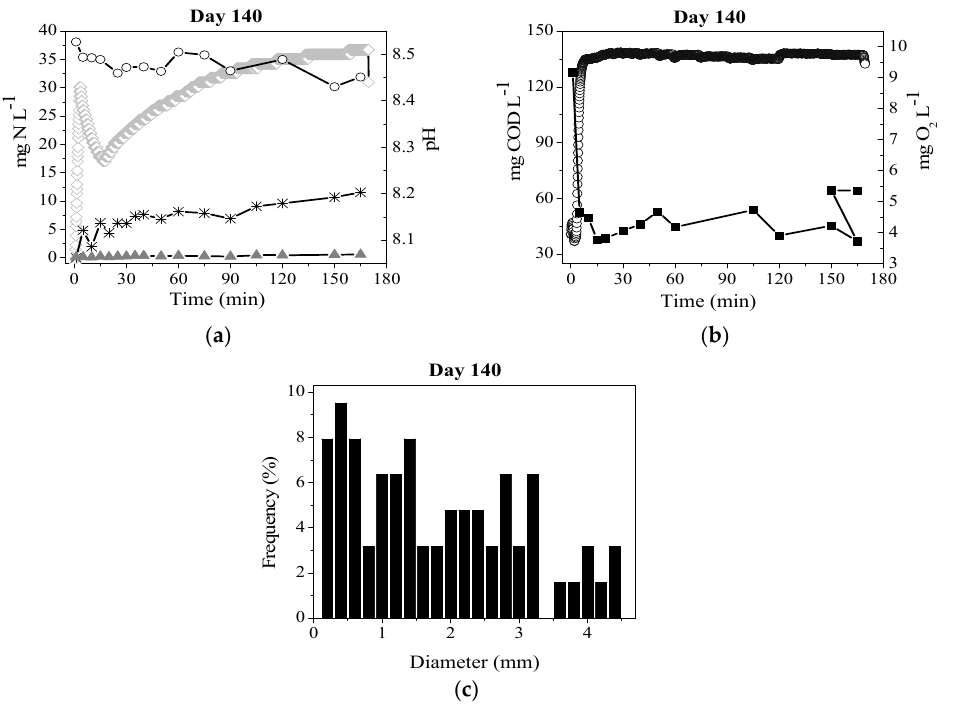
Figure 5. Cycle profile on day 140 with aeration rate of 1.04 cm s − 1 . ( a ) Nitrogen compounds concentrations and pH: N ‐ NH 4+ ( ○ ), N ‐ NO 2 − (*), N ‐ NO 3 −− ( ▲ ), and pH ( ). ( b ) O 2 concentration ( ○ ) and soluble COD ( ■ ). ( c ) Granule size distribution.